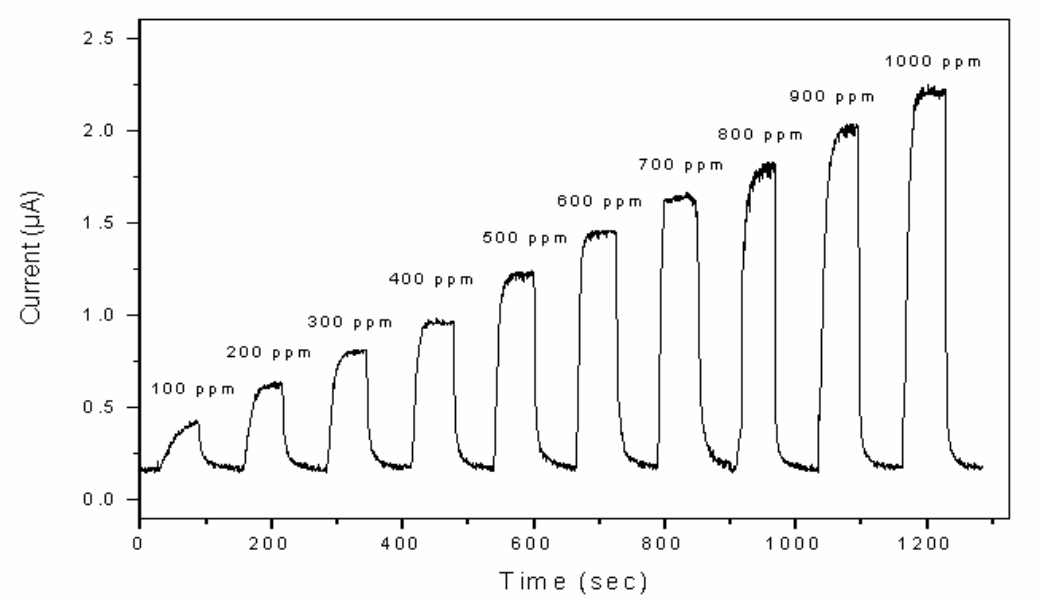
Figure 8. Response behaviour of the Pt | Nafion electrode sensor element with an area of 2 cm 2 prepared from 0.01 M Pt(NH concentration range of 100-1000 ppm.